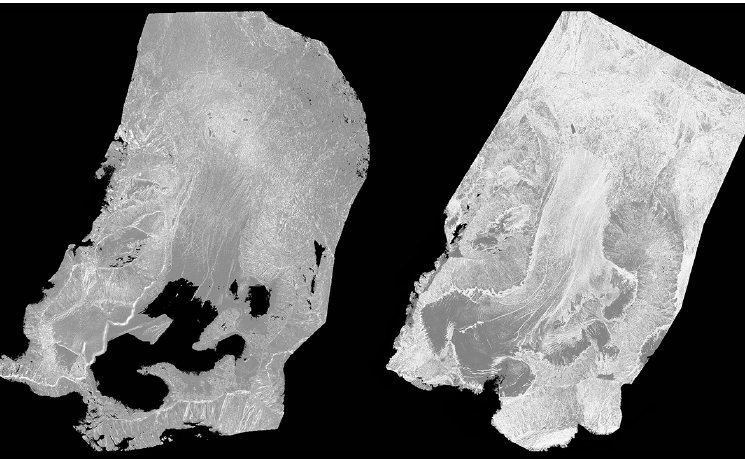
Figure 8. Correlation scores for 2014 (left) and 2015 (right) GoPro flights. White indicates perfect correlation, shades of grey imperfect correlation, and black no correlation. For both surveys, the accumulation area presents lower correlation scores (correlation even failed for the 2014 survey).